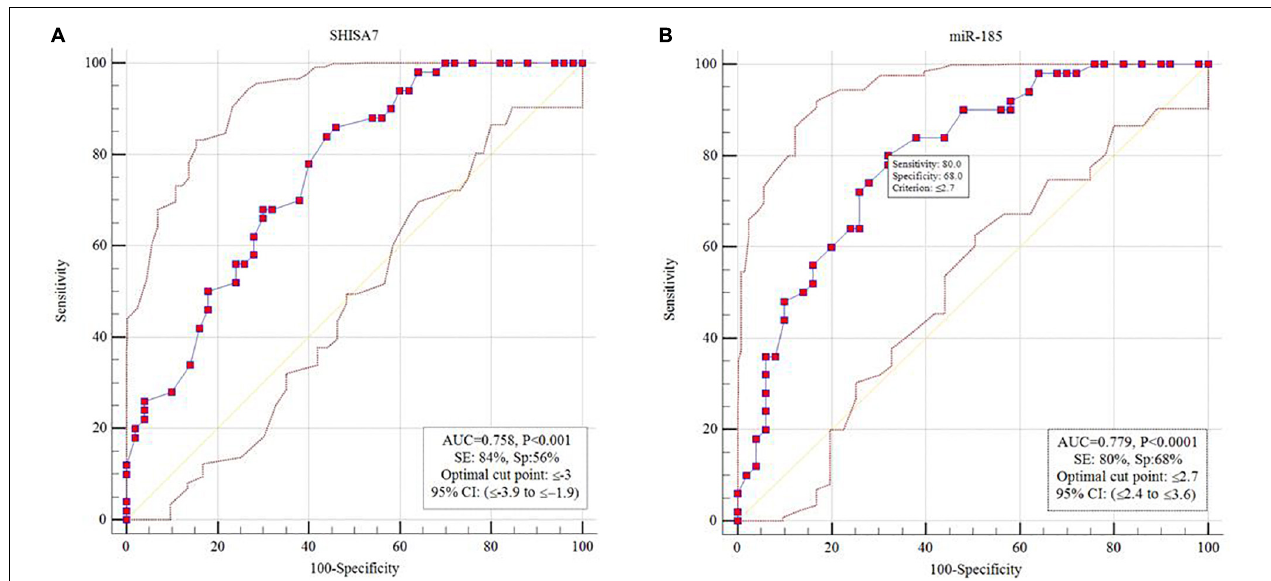
FIGURE 6 | Receiver operating characteristic (ROC) curve analysis. (A) SHISA7 transcript levels displayed diagnostic power of 0.758. (B) Hsa-miR-185-5p transcript levels displayed diagnostic power of